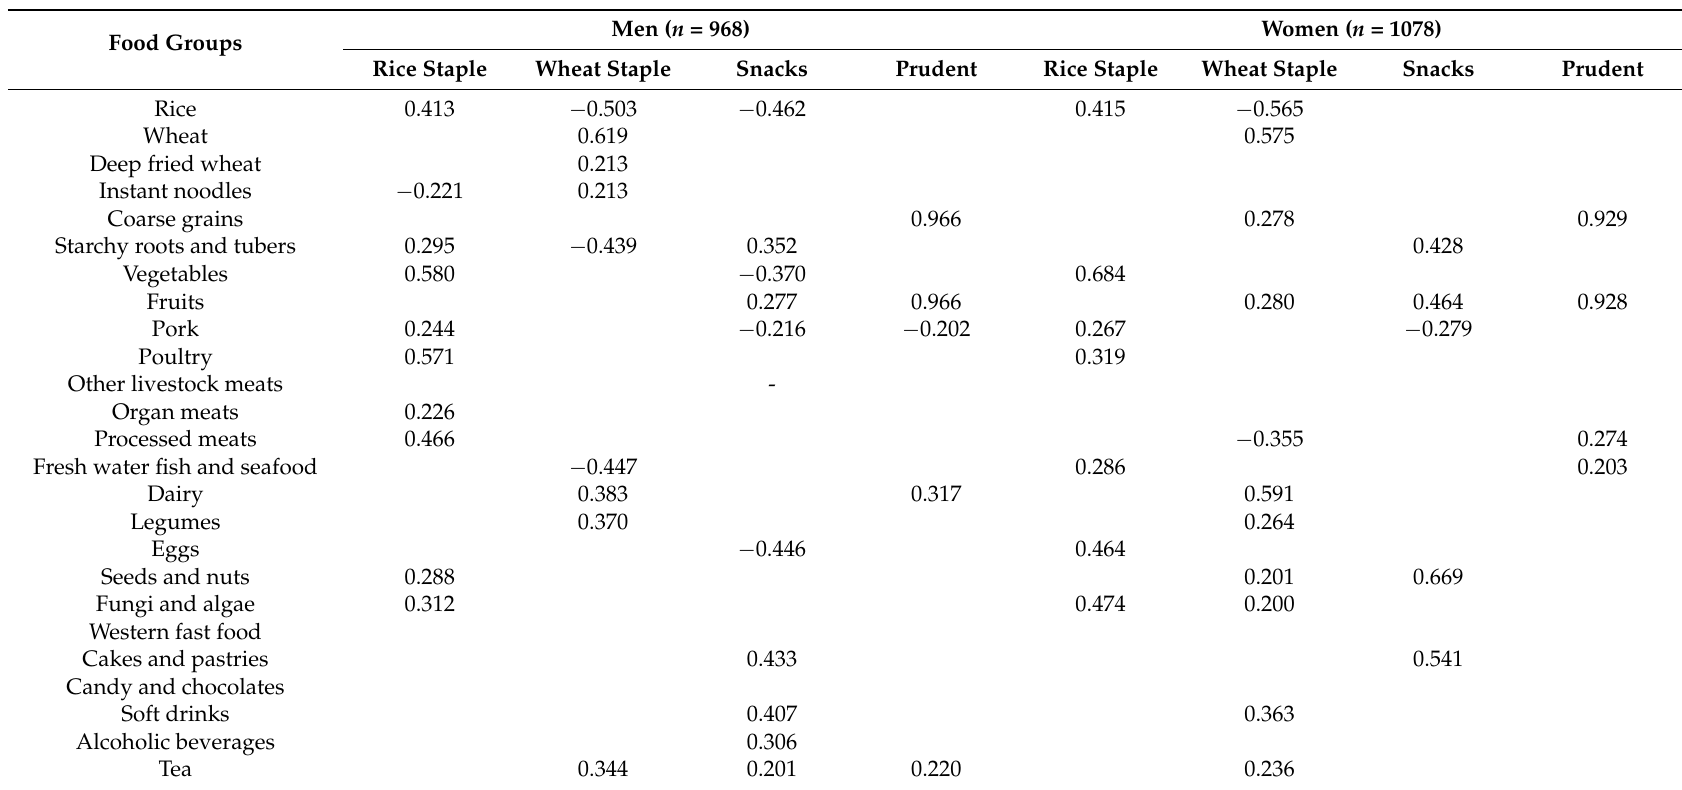
Table 3. Factor-loading matrix for dietary patterns among 2046 Shanghai residents aged over 45